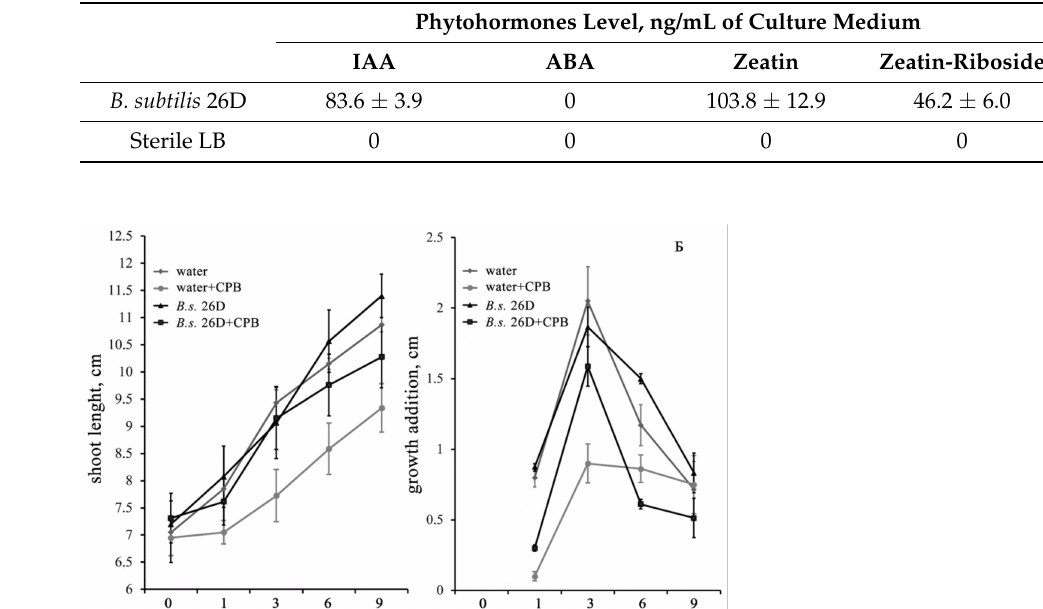
Table 1. Content of phytohormones in the culture medium of B. subtilis 26D strain.